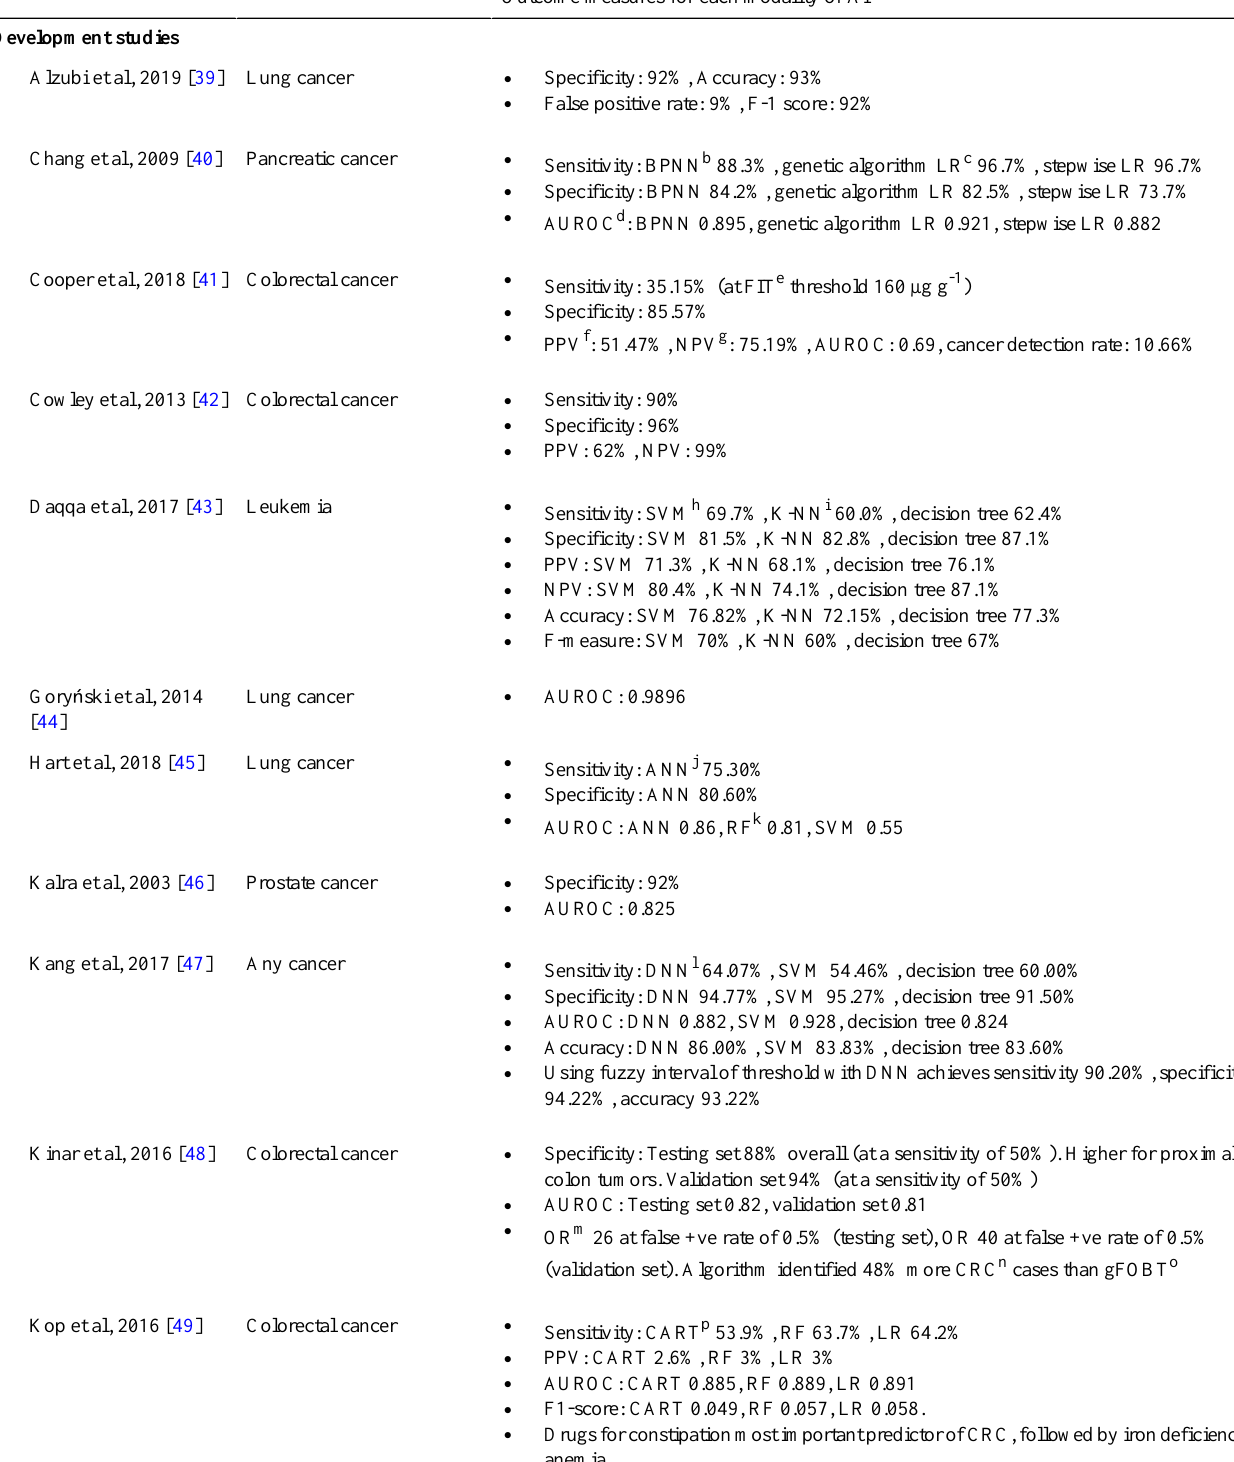
Outcome measures for each modality of AI a Cancer typeStudy